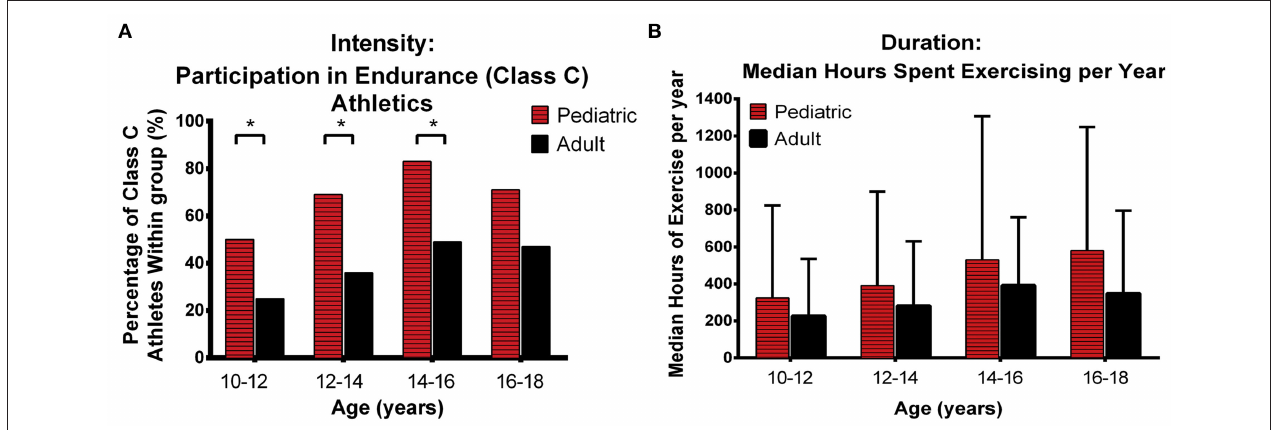
FIGURE 10 | Comparison of exercise intensity and duration during adolescence between patients with pediatric and adult-onset ARVC. Pediatric patients were engaged in higher intensity exercise (A) and performed more annual hours of exercise (B) during adolescence than arrhythmogenic right ventricular cardiomyopathy patients with Adult onset. Error bars indicate 95% confidence interval. * indicates statistically significant at p < 0.05. ARVD/C, arrhythmogenic right ventricular cardiomyopathy. Source: ( 11), obtained with